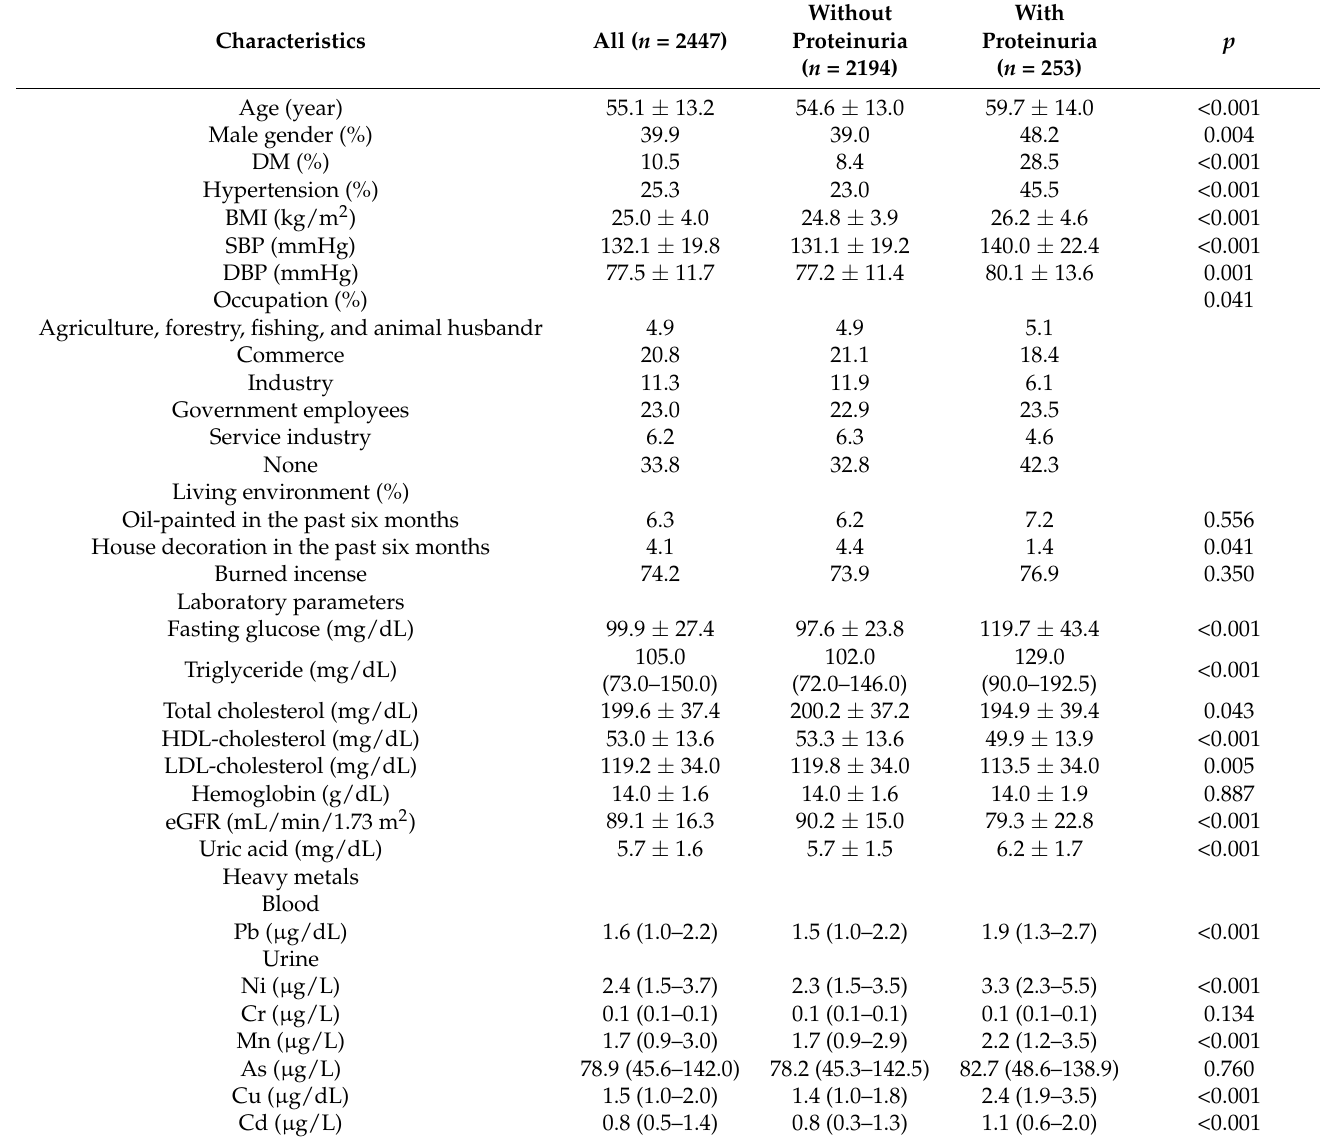
Table 1. Comparison of clinical characteristics among participants with and without